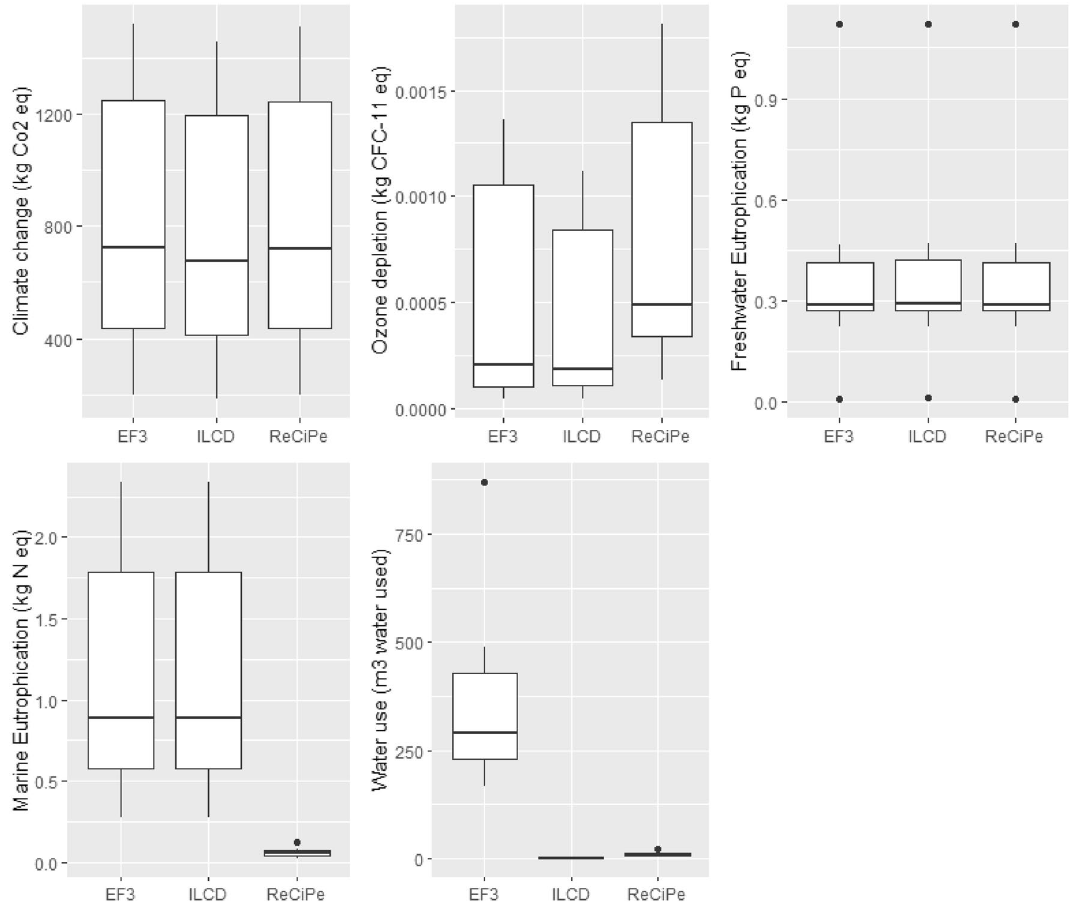
Figure 3. Sensitivity analysis of common impact categories (n = 3) across ReCiPe, ILCD and EF 3.0 impact assessment methods for the eight knotweed management approaches assessed in this LCA. In the box plots the center line = median; box limits = upper and lower quartiles; whiskers = 1.5 × interquartile range; points = outliers.